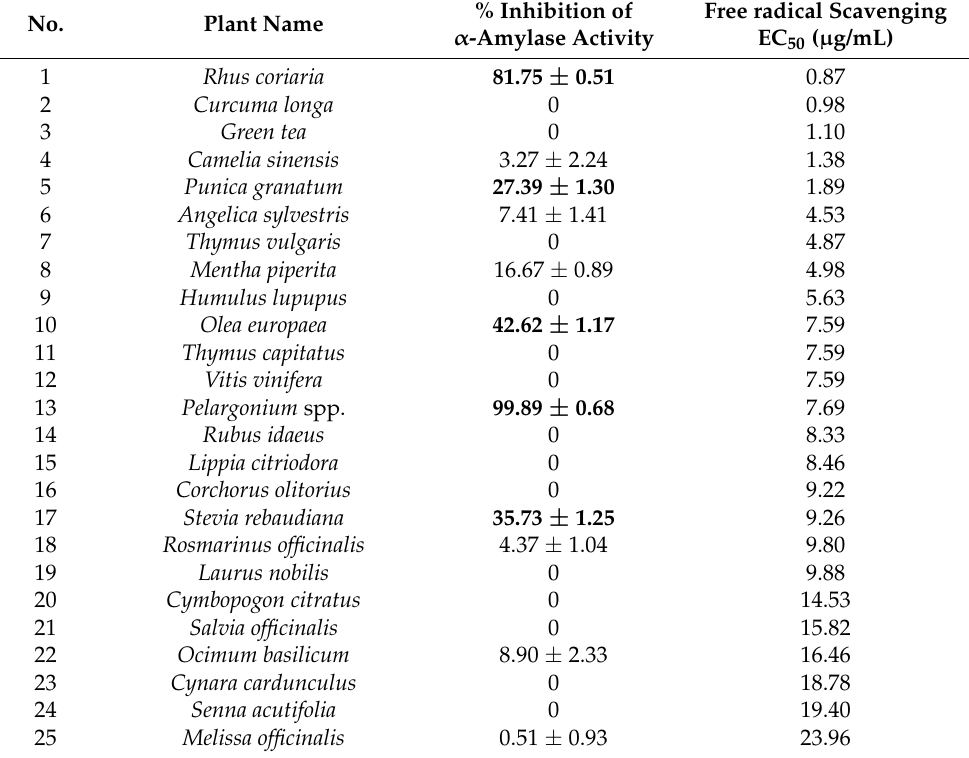
Table 1. Medicinal/edible plant extract-driven inhibition of α -amylase activity and the EC 50 values for free radical-scavenging activity. Active extracts that inhibit α -amylase in a ratio above 25% are labeled in